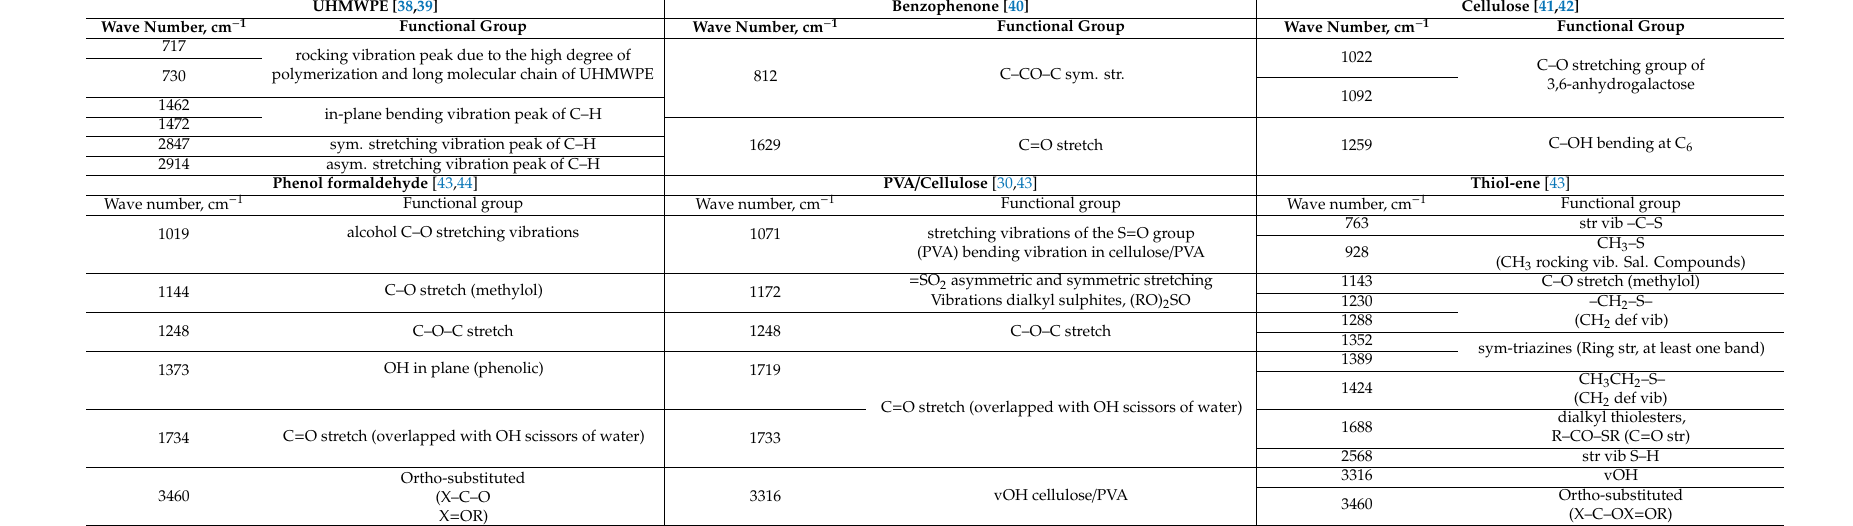
Table 6. The FT-IR spectrum peaks for all